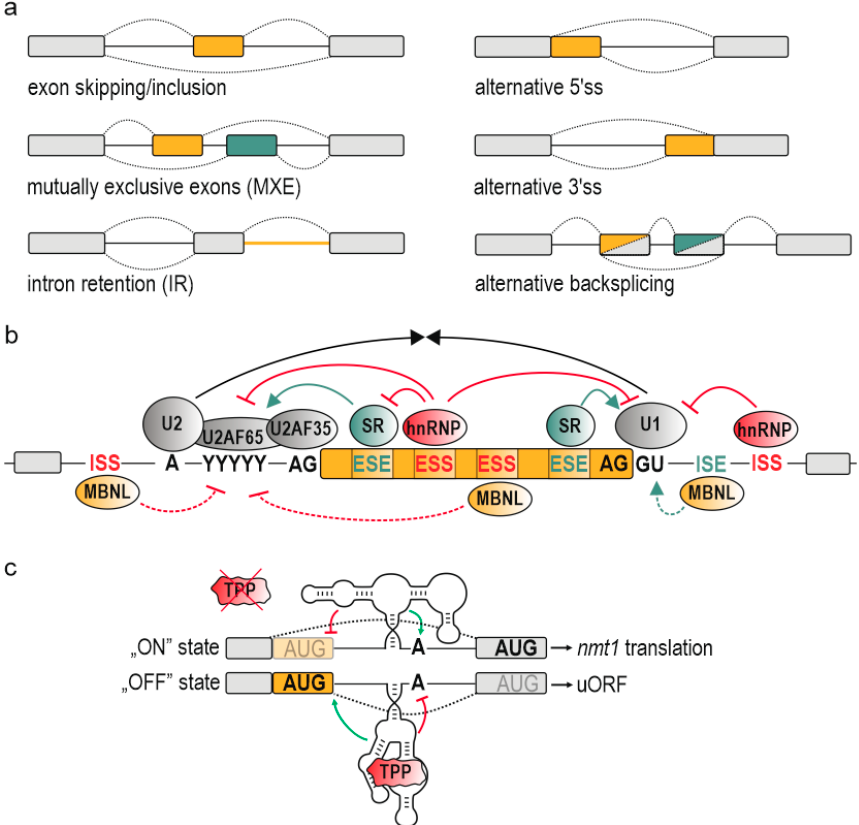
Figure 1. Schematic presentation of types of alternative splicing and its general regulation. ( a ) Different types of alternative splicing including alternatively spliced exons, introns, 5 ′ ss and 3 ′ ss. Alternative exons are marked in orange and green; constitutive exons are marked in grey. ( b ) Simplified scheme of alternative exon definition by components of spliceosome (marked in grey), auxiliary cis -acting elements (ESS, ESE, ISE, ESS, A, YYYYY) and trans -acting protein factors (SR, hnRNP, MBNL). Detail description is included in the main text. Alternative exon is marked in orange; SR, serine/arginine rich proteins; hnRNP, heterogenous nuclear ribonucleoprotein; MBNL, Muscleblind-like protein; ESE and ESS, exonic splicing enhancer and silencer, respectively; ISE and ISS, intronic splicing enhancer and silencer, respectively; A, branch point; YYYYY, Py-tract; green arrows, positive splicing regulation; red arrows, negative splicing regulation; black arrows, reciprocal relation of spliceosome components for exon definition. ( c ) Fungal riboswitch within intron 1 of N-myristoyltransferase 1 ( nmt1 ) gene [52]. It base pairs with alternative 5 ′ ss enabling the selection of an upstream 5 ′ ss and production of a functional nmt1 protein (“ON” state). Under excess of thiamine pyrophosphate (TPP) ligand, the TPP recognizes and binds to this RNA element imposing its structural alterations as well as rearranging the accessibility of adjacent cis -acting elements. In consequence, alternative 5 ′ ss and upstream translation initiation codon are selected leading to reduction of nmt1 expression (“OFF” state). uORF, upstream open reading frame.